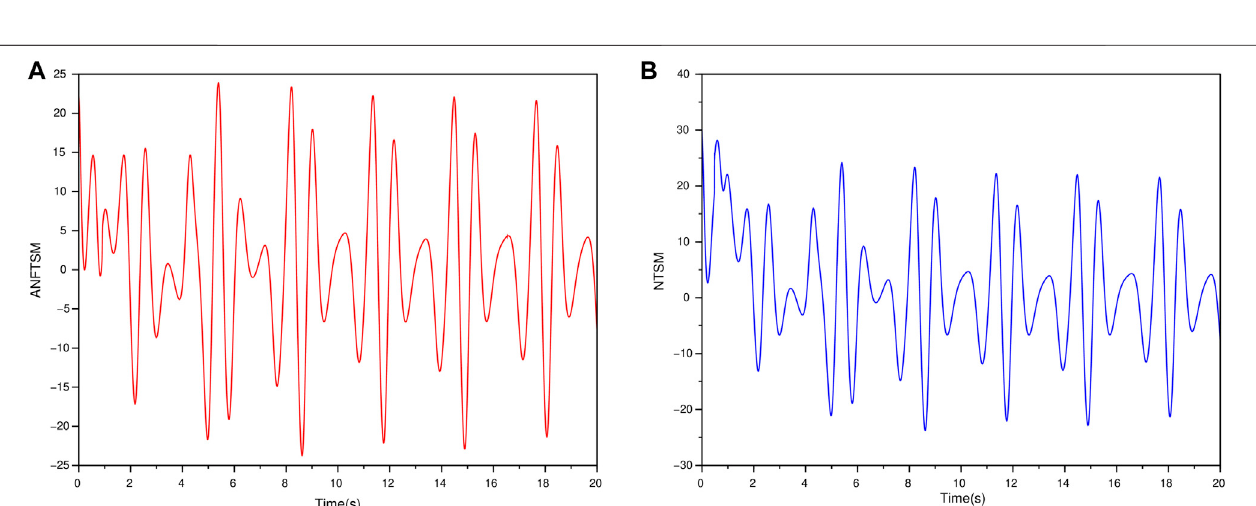
FIGURE 6 | The time response of the design controller u ( t ) in Example 1 (A) the ANFTSM controller (B) the NTSM controller.